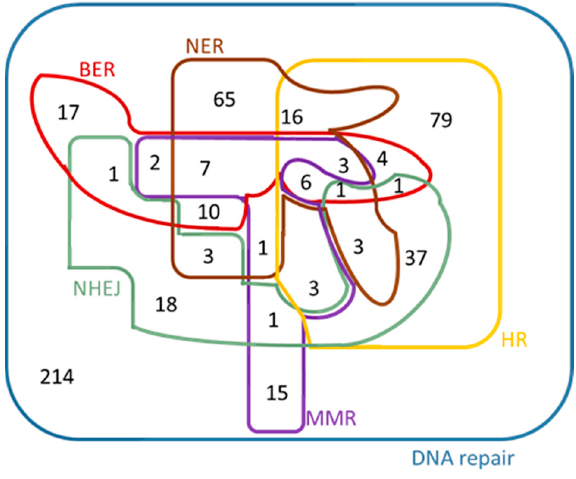
Figure 5. Venn diagram of the Homo sapiens genes that were found under each of the GO terms listed in Table 4.